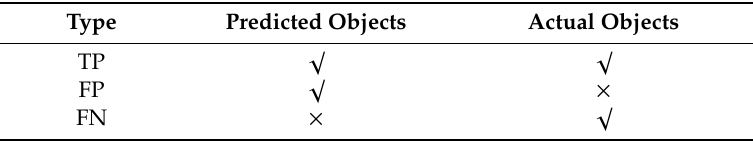
Table 3. Definitions of TP, FP and FN for component detection.